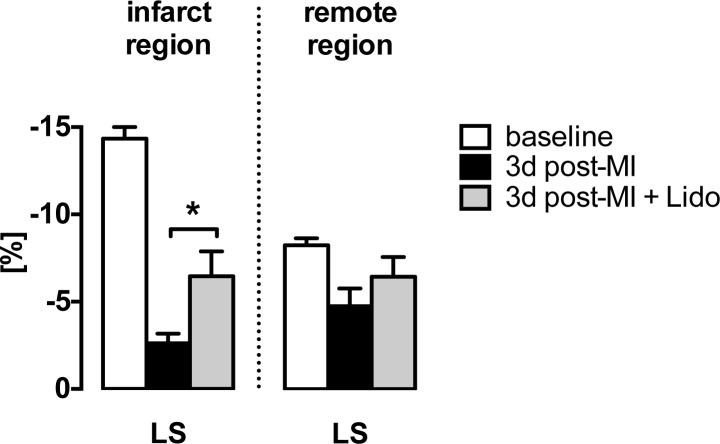
Lidocaine improves residual function of ischemic myocardium.Regional LS of segments of the infarcted region (MA, AA, AI) and the non-ischemic, remote region (BI, MI) are shown. Treatment with lidocaine results in improved LS following LAD ligation in the infarcted region (gray bars) as compared to mice receiving vehicle (black bars), while no effect of lidocaine is apparent in the remote region. LS longitudinal strain, MA mid-anterior, AA apical-anterior, AI apical-inferior, BI basal-inferior, MI mid-inferior; *p = 0.0167.